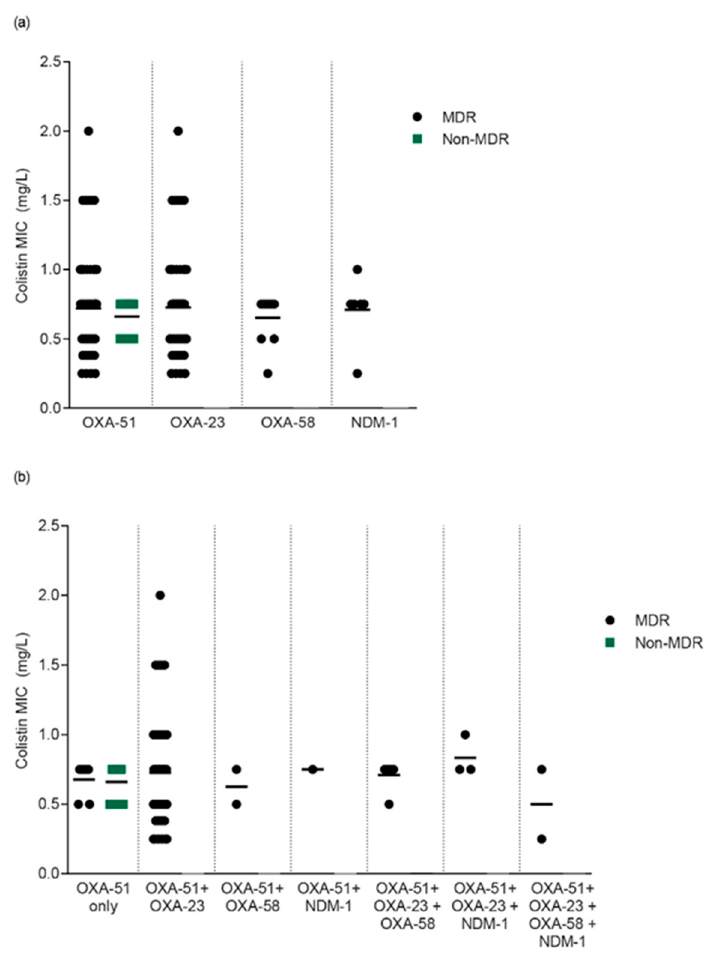
Figure 4. Relationship of Ab genotypes, level of drug resistance, and colistin minimum inhibitory concentrations (MIC) values.